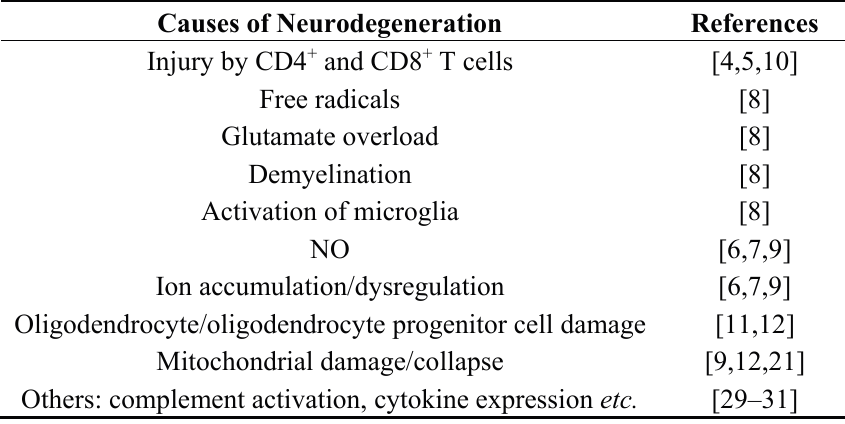
Table 1. Causes of